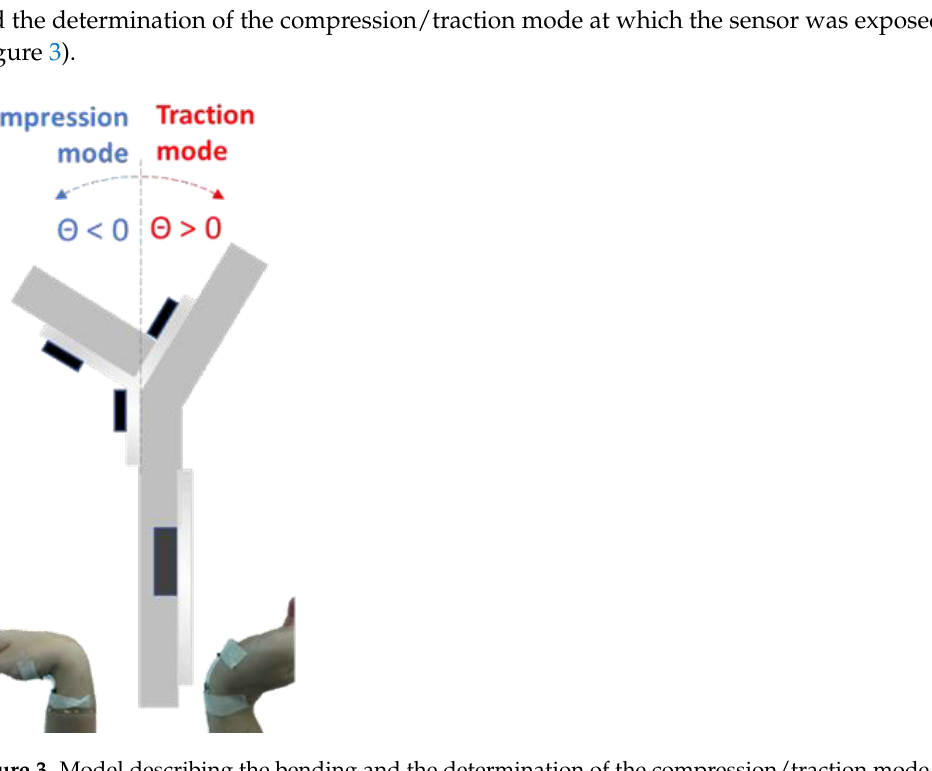
Figure 3. Model describing the bending and the determination of the compression/traction mode.